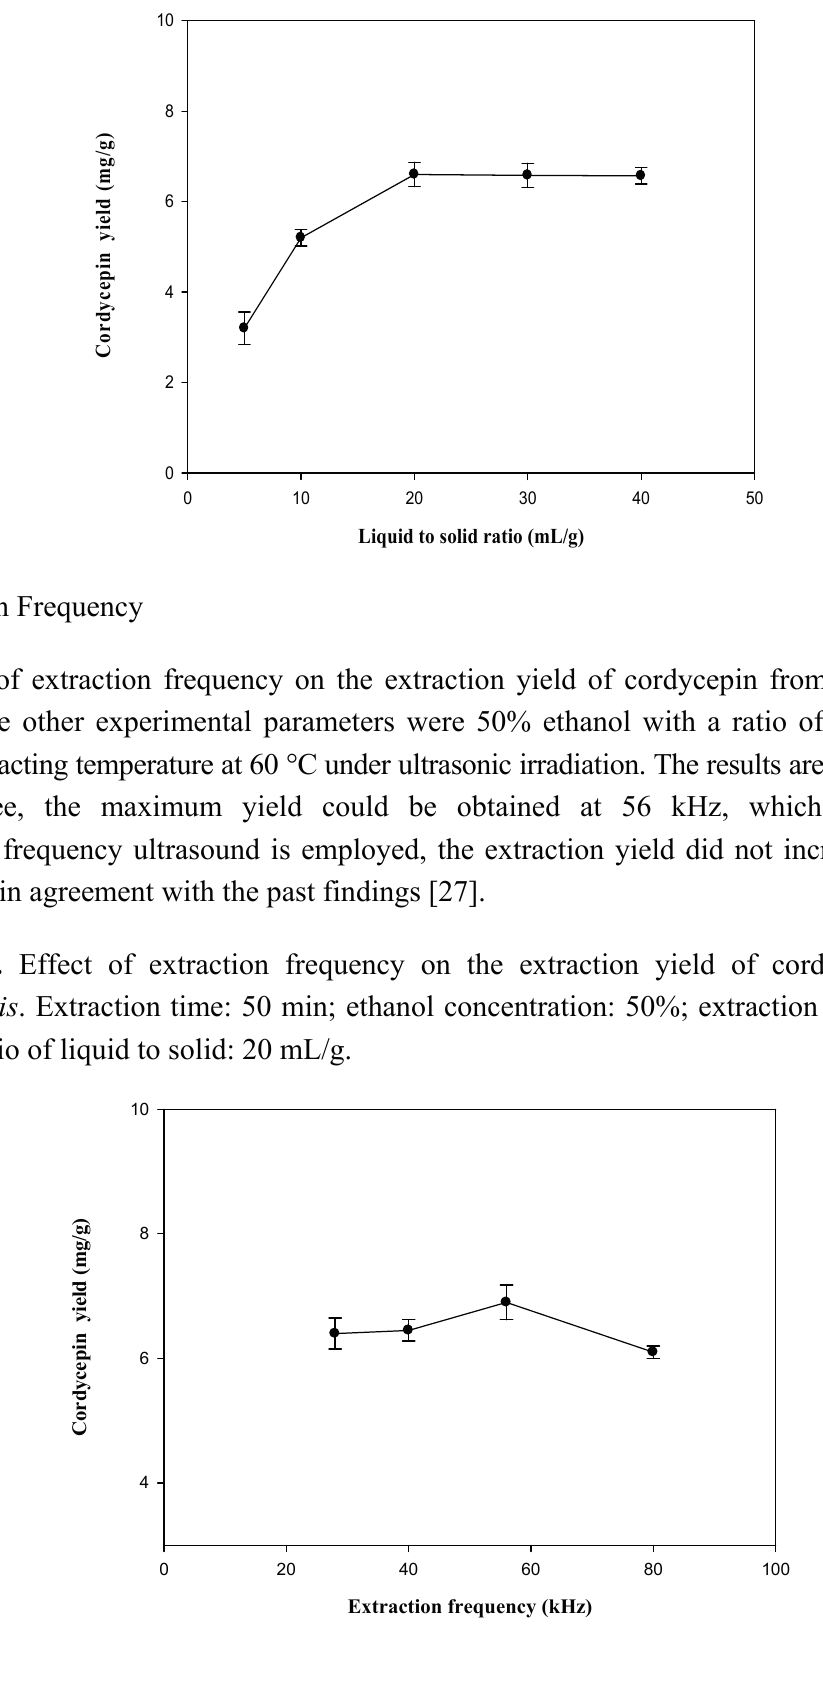
Figure 5. Effect of ratio of liquid to solid on the extraction yield of cordycepin from C. militaris . Extraction time: 50 min; ethanol concentration: 50%; extraction temperature: 60 °C; extraction frequency: 40 kHz.